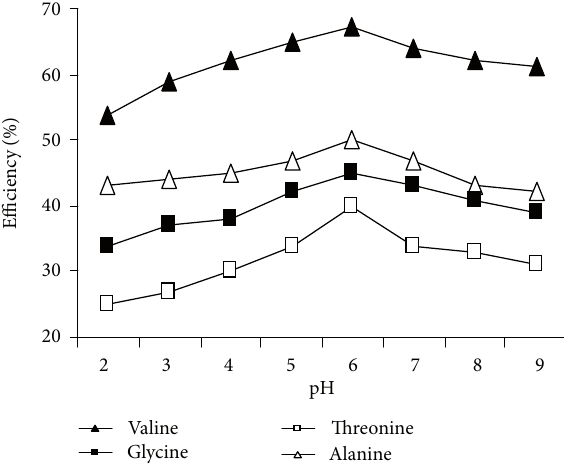
F 7: Effect of pH. Concentration of amino acid in source phase M. Concentration of krypto�x 5 = = −3 5.0×10